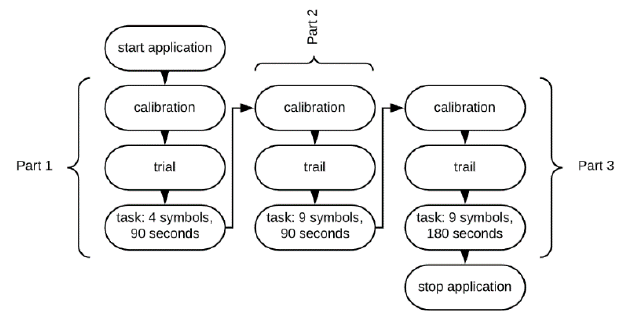
Figure 2. The procedure of the experiment.